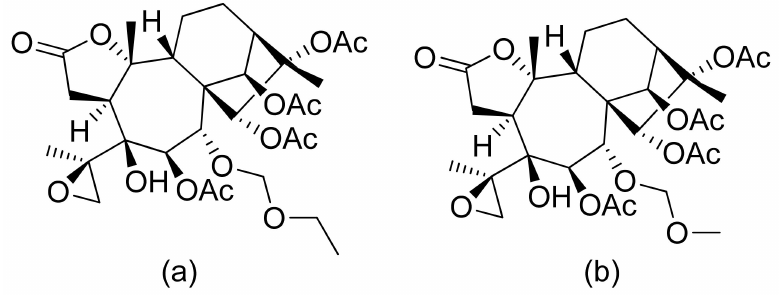
Figure 20. Antifeedant lactones from Pieris Formosa ( a , b ) .